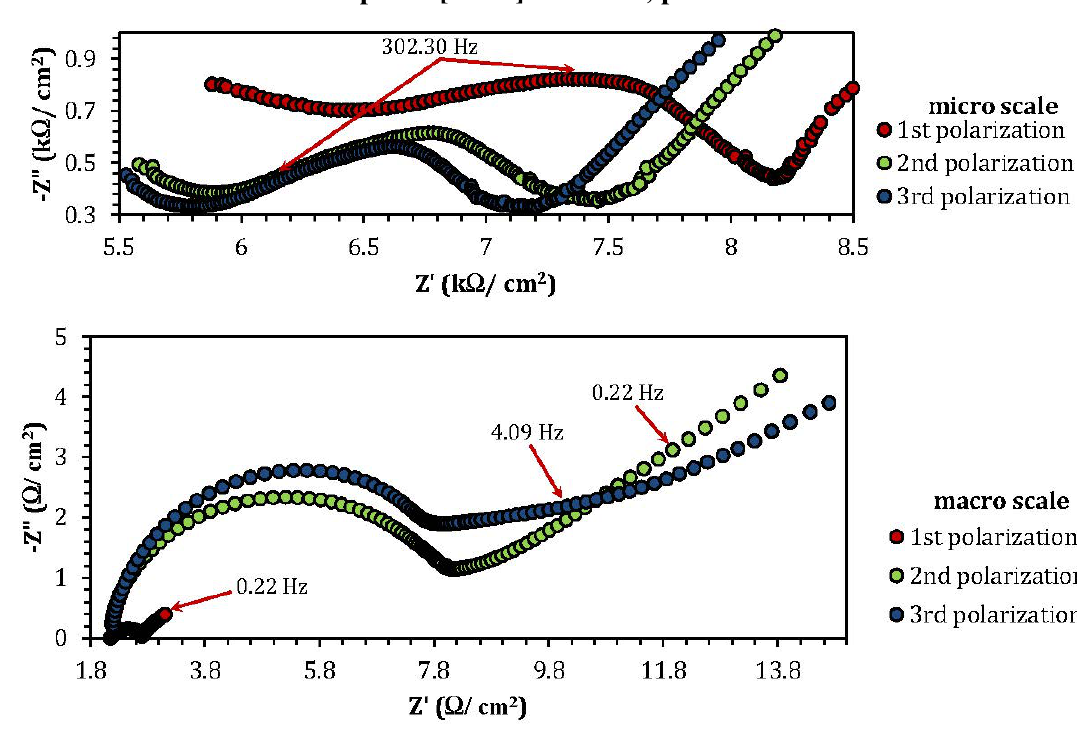
Exp. #5: [NaCl] = 5 M, pH =